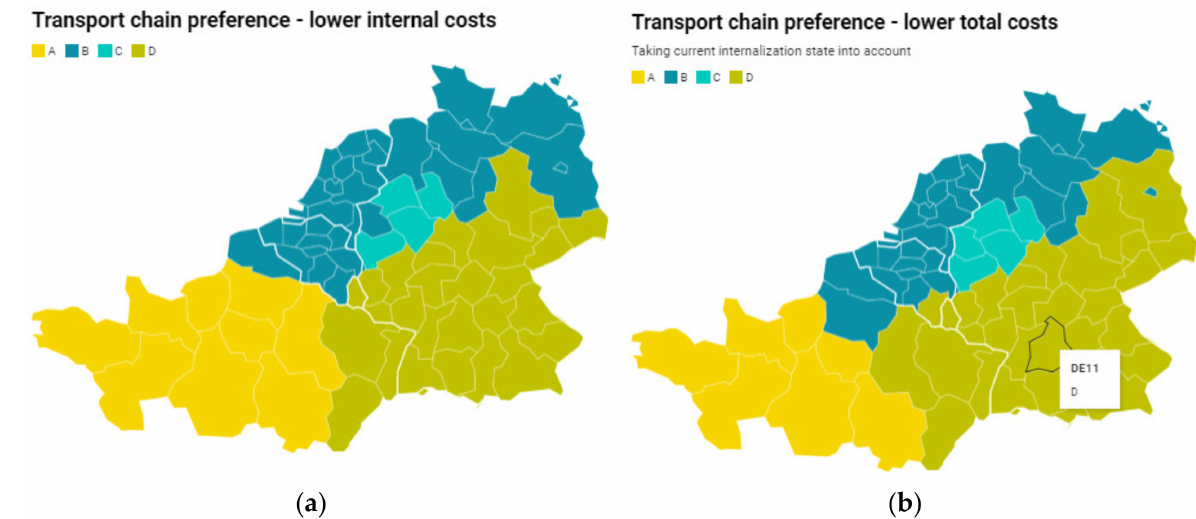
Figure 10. Transport chain preference: ( a ) for lower internal costs; ( b ) for lower total costs taking the current internalization state into account (created with